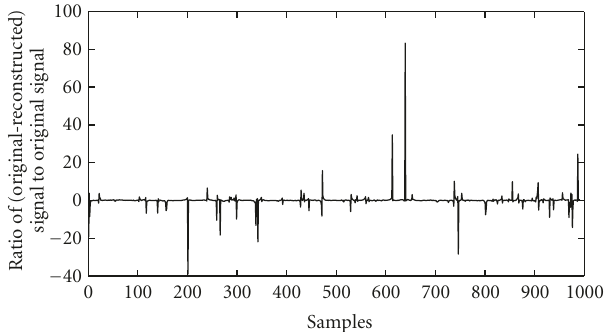
Figure 6: A plot of PARE for the signals shown in Figure 8. Errors between original and reconstructed samples are depicted as spikes in this plot.